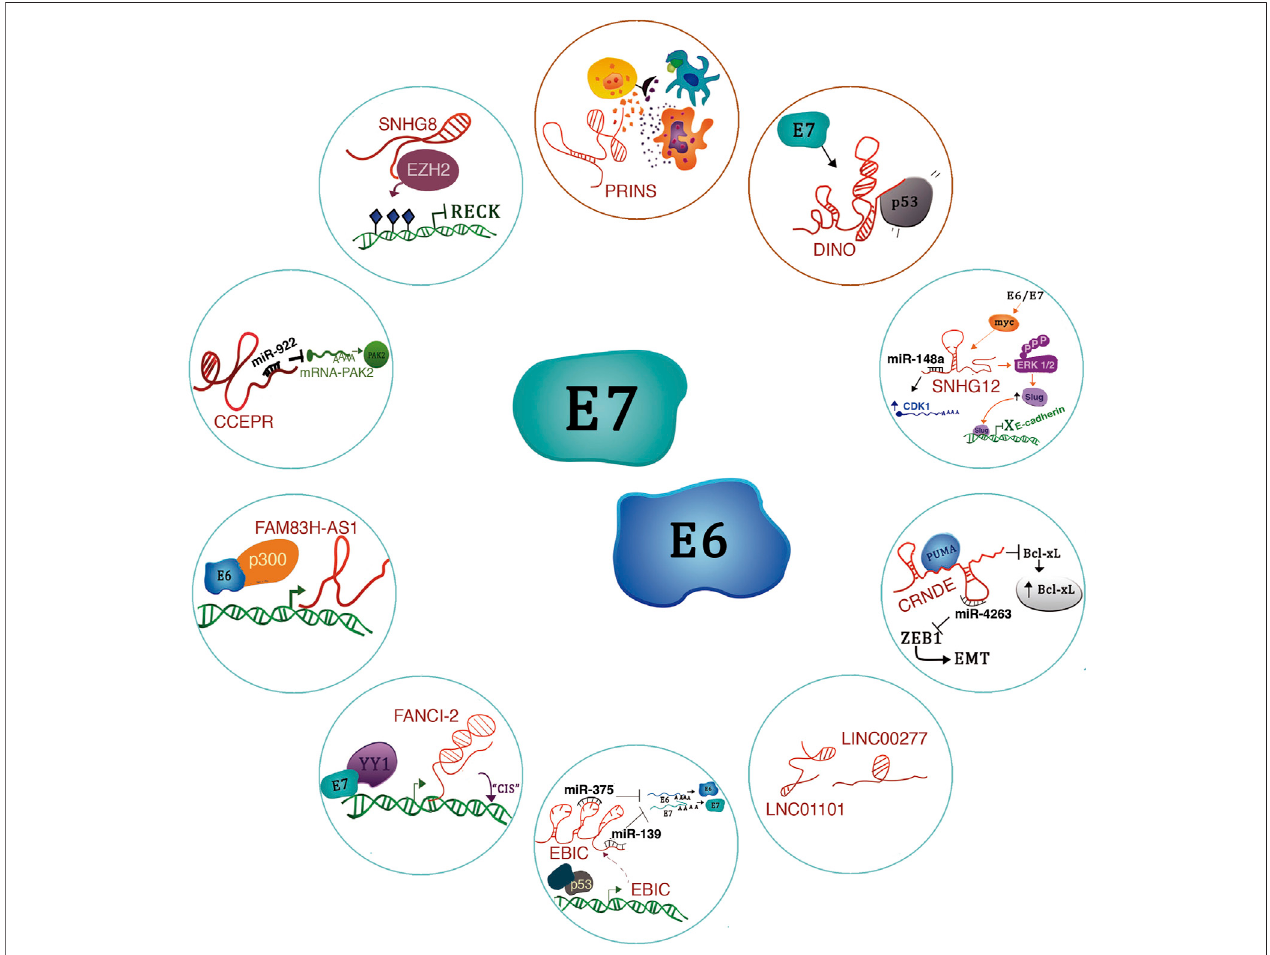
FIGURE5| lncRNAsregulatedbyE6/E7oncoproteins.The fi gureshowsthemolecularmechanismsoflncRNAsregulatedbytheE6/E7oncoproteins.Bluecircles refer to oncogenic lncRNAs and red circles to tumor suppressors.